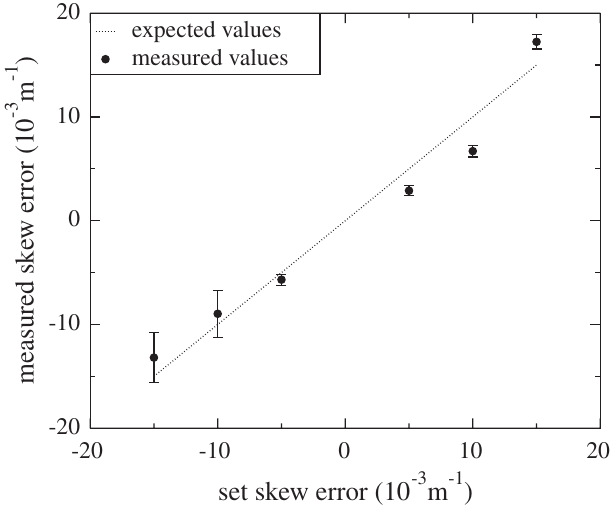
FIG. 9. Relation between the skew quadrupole errors inten- tionally introduced in the accelerator and the measured errors obtained from action and phase analysis of RHIC difference